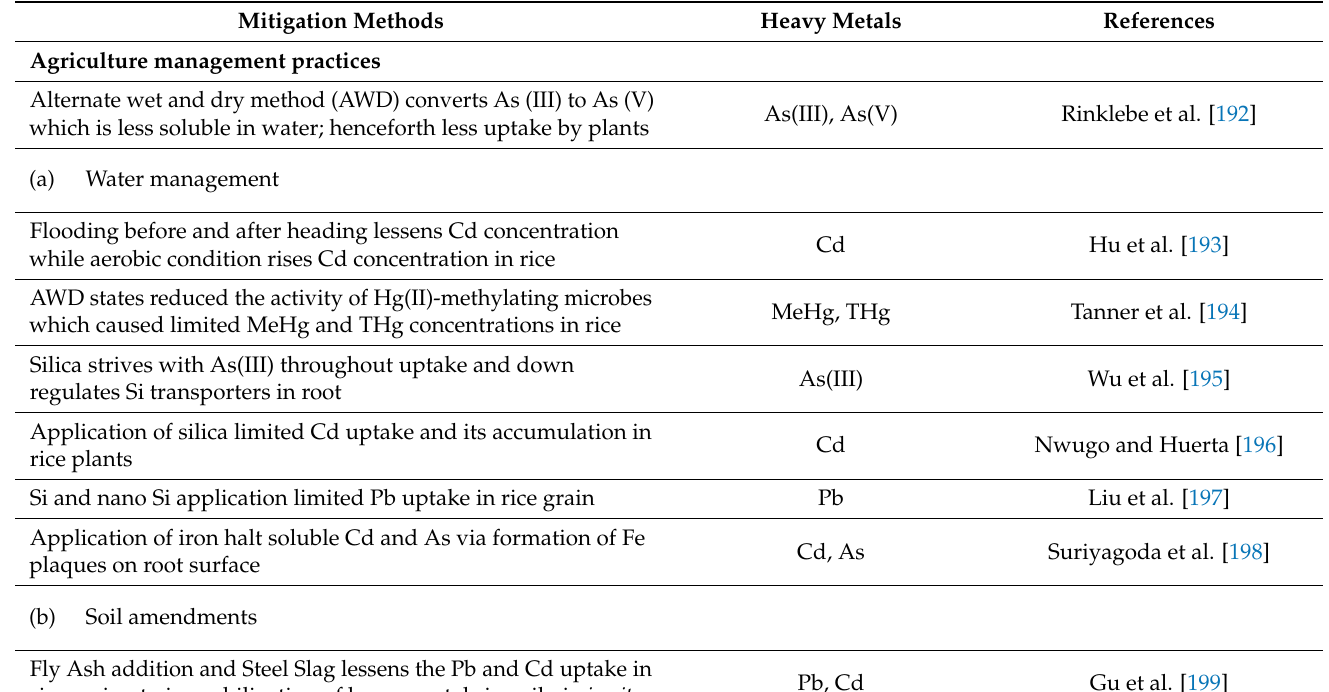
Table 7. Mitigation methods for reducing heavy metals availability in rice